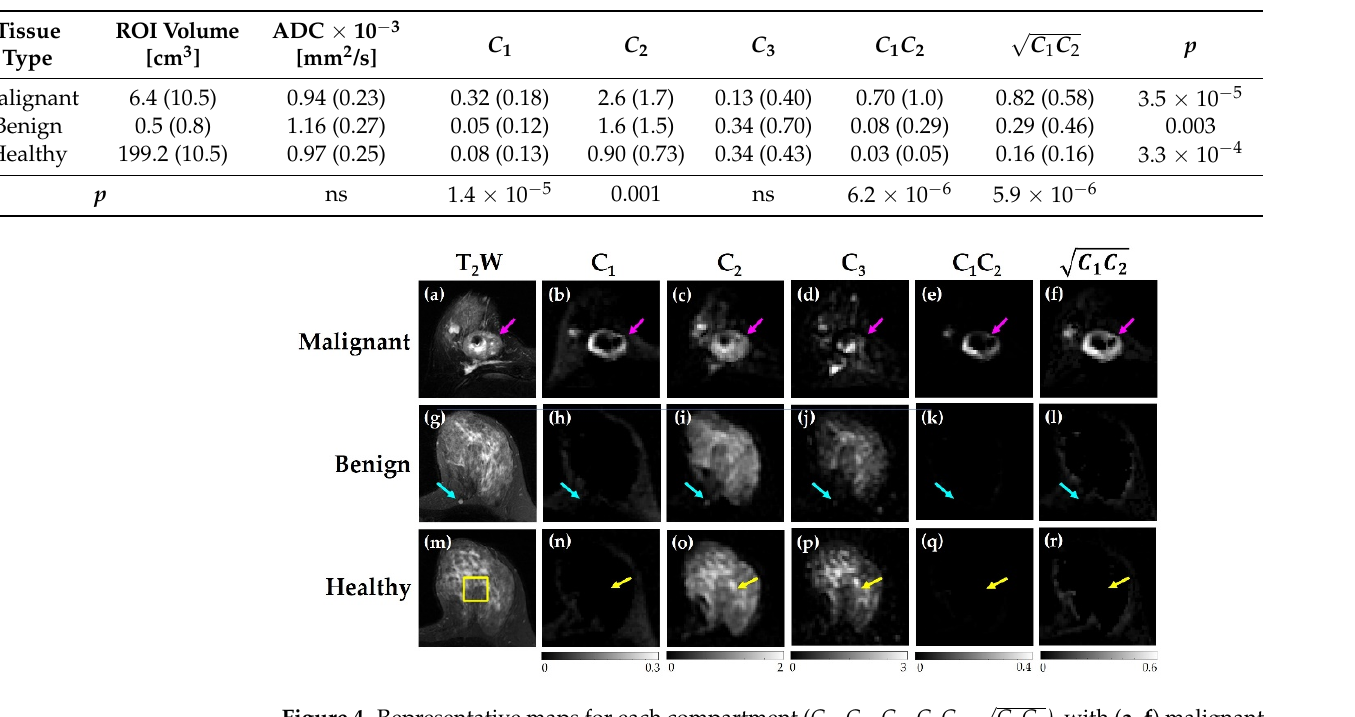
Table 2. Summary of ROI and compartment map values. Data are reported as median (interquartile range). Ranked two-way repeated measures ANOVA results are indicated in the last column and row (across compartment and tissue type, respectively) (ns: p > 0.05).